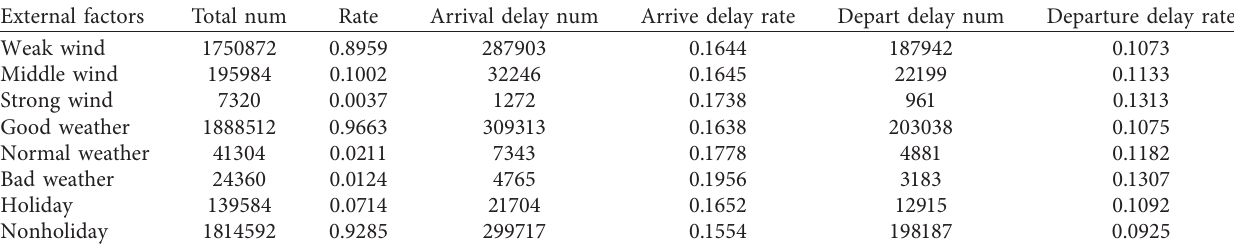
Table 4: Changes of departure rate and arrival rate under the influence of external factors.